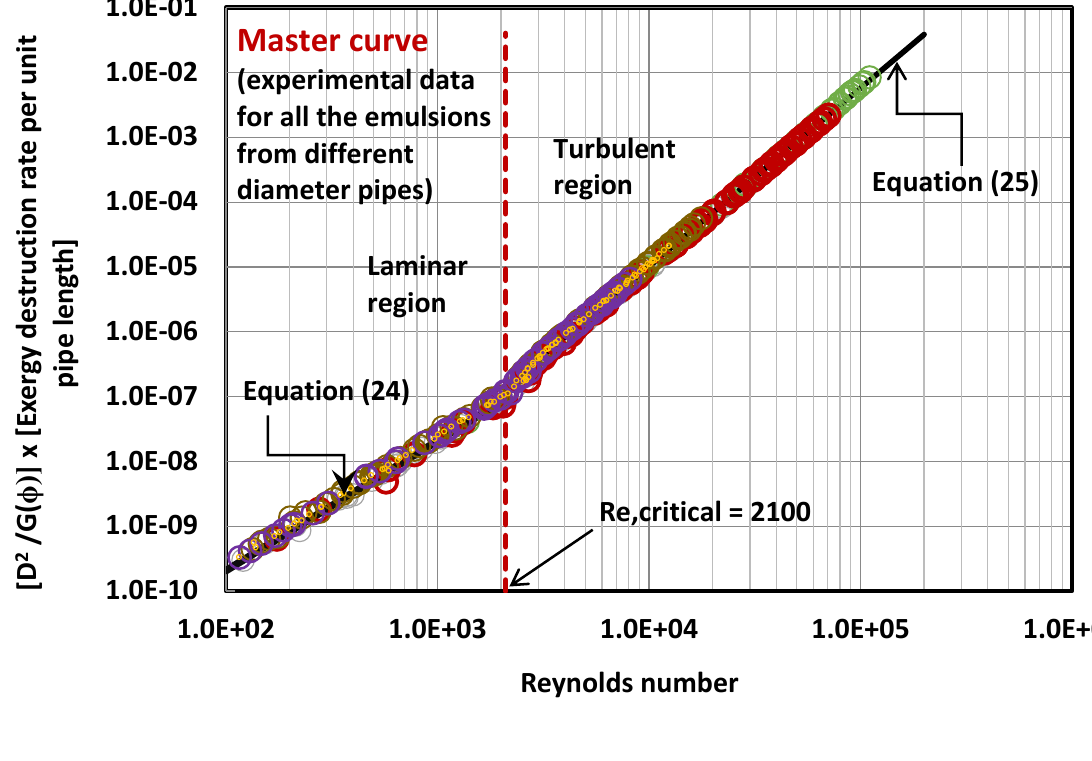
  versus Re plot, covering all the experimental Figure 14. Master curve, )φ(/ 2 GD D exergy destruction data for surfactant-stabilized O/W